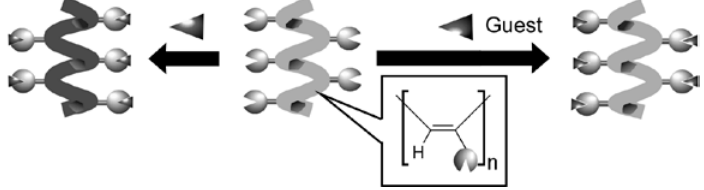
Figure 2. Helicity inversion based on guest